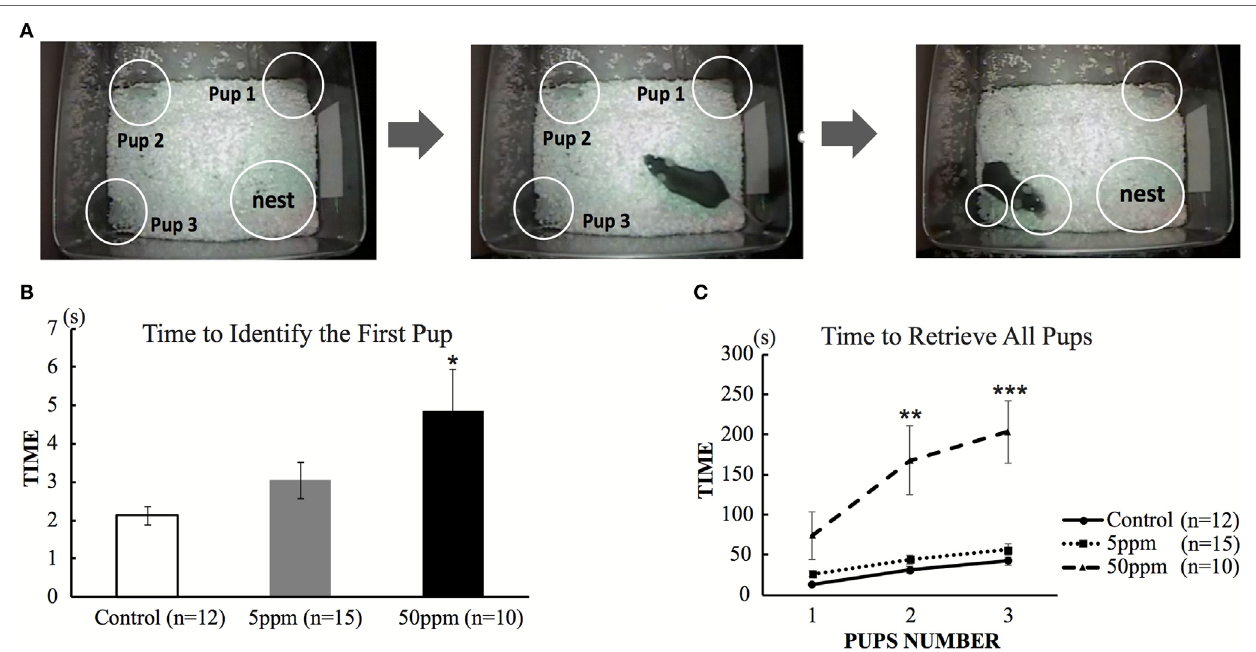
FigUre 5 | The effect of propylthiouracil treatment during in utero and postnatal periods on maternal behavior. (a) Pup retrieval test procedure. Three pups were placed in each corner followed by reintroduction of the dam into the cage. The time until the dam recognized the first pup by touching by it with nose and until the dam collected all three pups back in the nest were counted. (B) Time required to identify the first pup. The time was longer in mice from the 50 ppm group. (c) Time required to retrieve all three pups. The time was longer in mice from the 50 ppm group. Data are the mean ± SEM, * p < 0.05; ** p < 0.01; *** p < 0.001 compared to the control group by ANOVA and Bonferroni